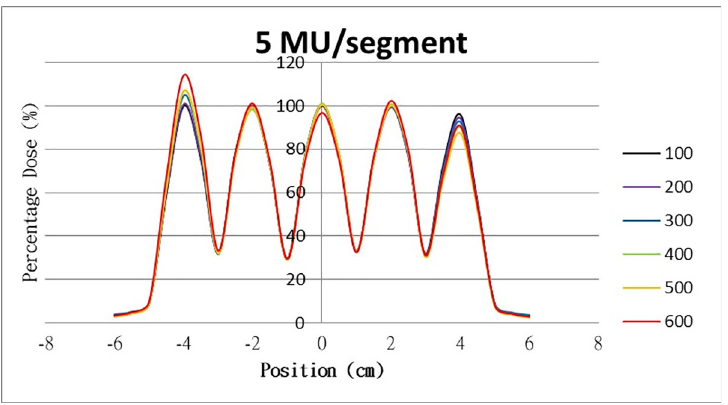
Fig 10. Overshoot effect measured at various MU values and dose rates. Overshoot effect, at various dose rates, for (6) 1 MU, (7) 2 MU, (8) 3 MU, (9) 4 MU, (10) 5 MU, (11) 6 MU, (12) 7 MU, (13) 8 MU, (14) 9 MU, (15) and 10 MU.